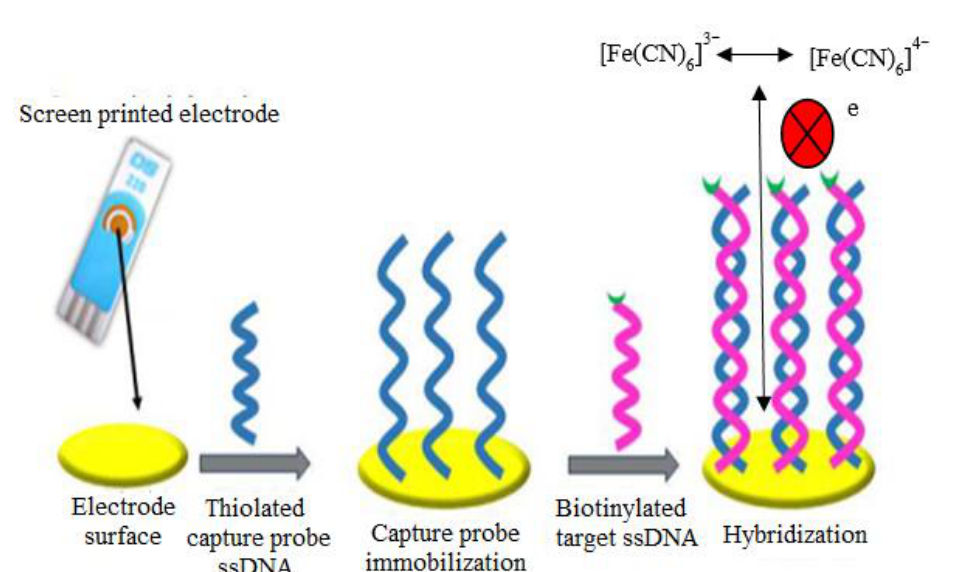
Figure 9. The illustration diagram represents the detection of target DNA by using a capture probe (SH-DNA) immobilized onto the SPE surface. In the presence of target DNA, the electron transfer is blocked due to the electrostatic repulsion that occurs between the interaction of [Fe(CN) 6 ] 3 − /4 − with dsDNA. Reproduced from Ilkhani and Farhad